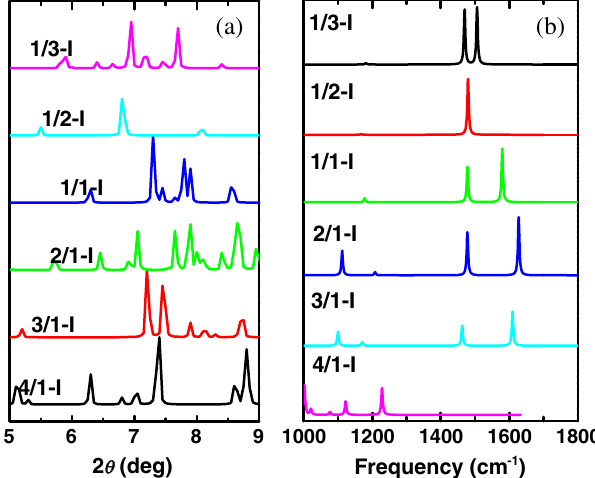
FIG. 4 (color online). The simulated (a) XRD spectra and (b) IR spectra of the most stable structure for each stoichiometric